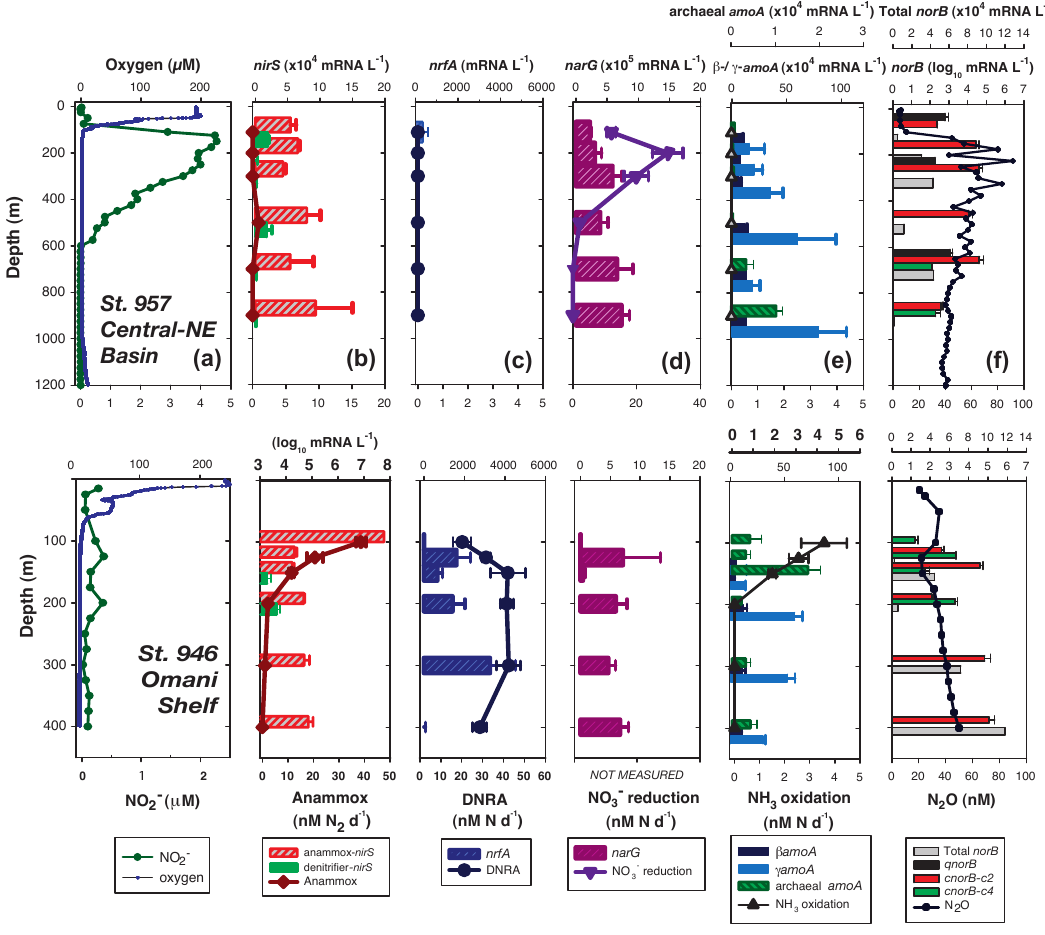
Fig. 3. Typical vertical distributions of various chemical and N-cycling functional gene expressions observed in the central-northeastern Arabian Sea OMZ (St. 957, upper panels) and the Omani Shelf OMZ (St. 946, lower panels): (a) oxygen and NO − and the expression of anammox- and denitrifier- nirS genes, (c) DNRA rates and nrfA expression, (d) nitrate reduction rates and narG expression, (e) ammonia oxidation rates, crenarchaeal and bacterial amoA expressions, (f) N 2 O and the expression of various forms of quinol- and cytochrome-containing norB genes. The N 2 O profile for central-NE basin was obtained from St. 950. Please note the different scales used to accommodate the much higher values obtained over the shelf as highlighted in bold. Error bars for rates are standard errors calculated from linear regression, and those for gene expressions represent standard deviations from triplicate real-time PCR runs. Although denitrification rate measurements were made, there was no convincing evidence of its active